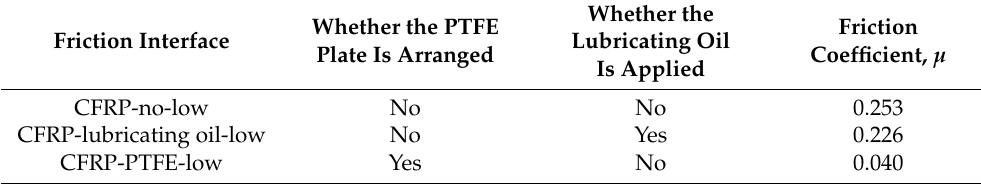
Table 3. Friction coefficient determination working